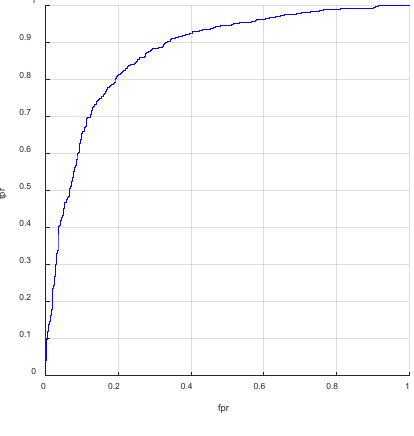
Figure 6. The ROC curve of our diagnostic